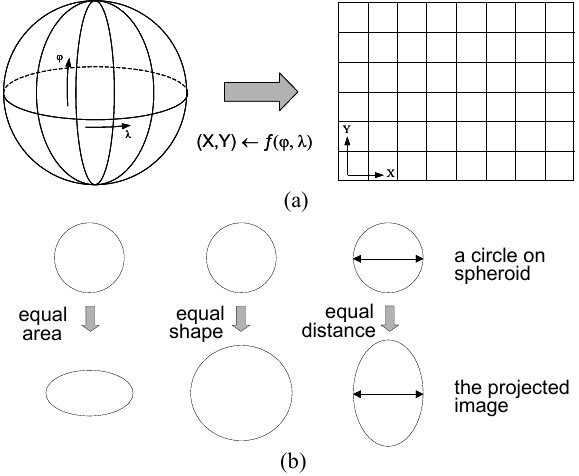
Figure 1. Map projection as a function (a); and the expected distortions